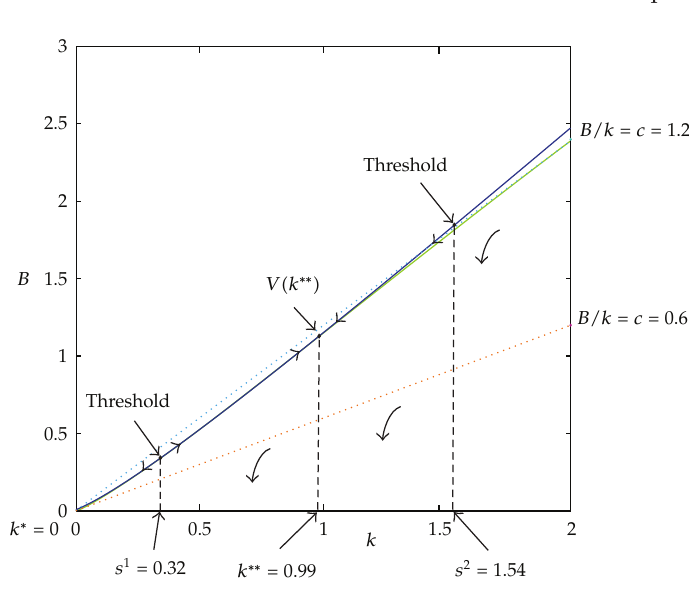
Figure 4: Present value curve V (cid:3) k (cid:6) for debt ceilings, H (cid:3) k,B (cid:6) from (cid:3) 3.1 (cid:6)